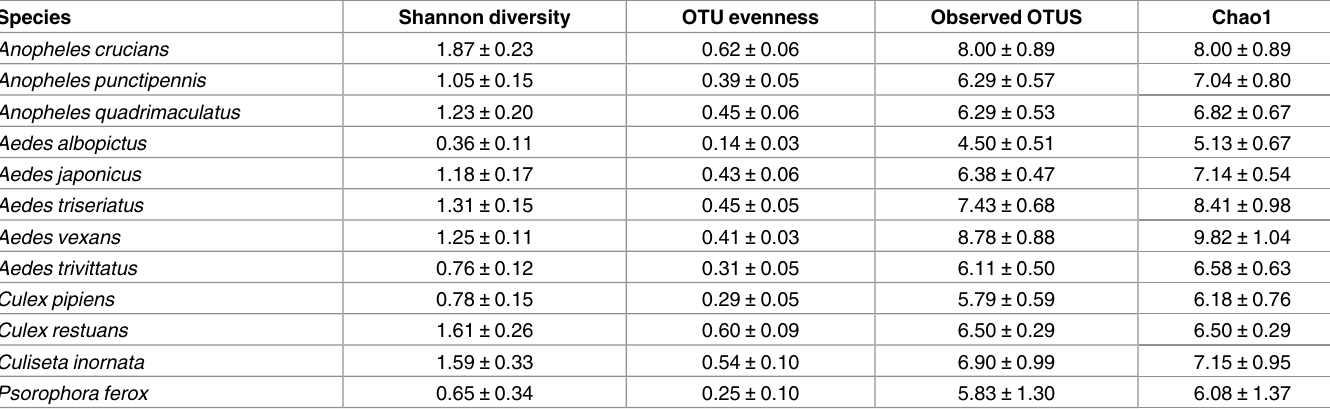
Table 2. Bacterial diversity and richness (mean ± SE) in the guts of 12 mosquito